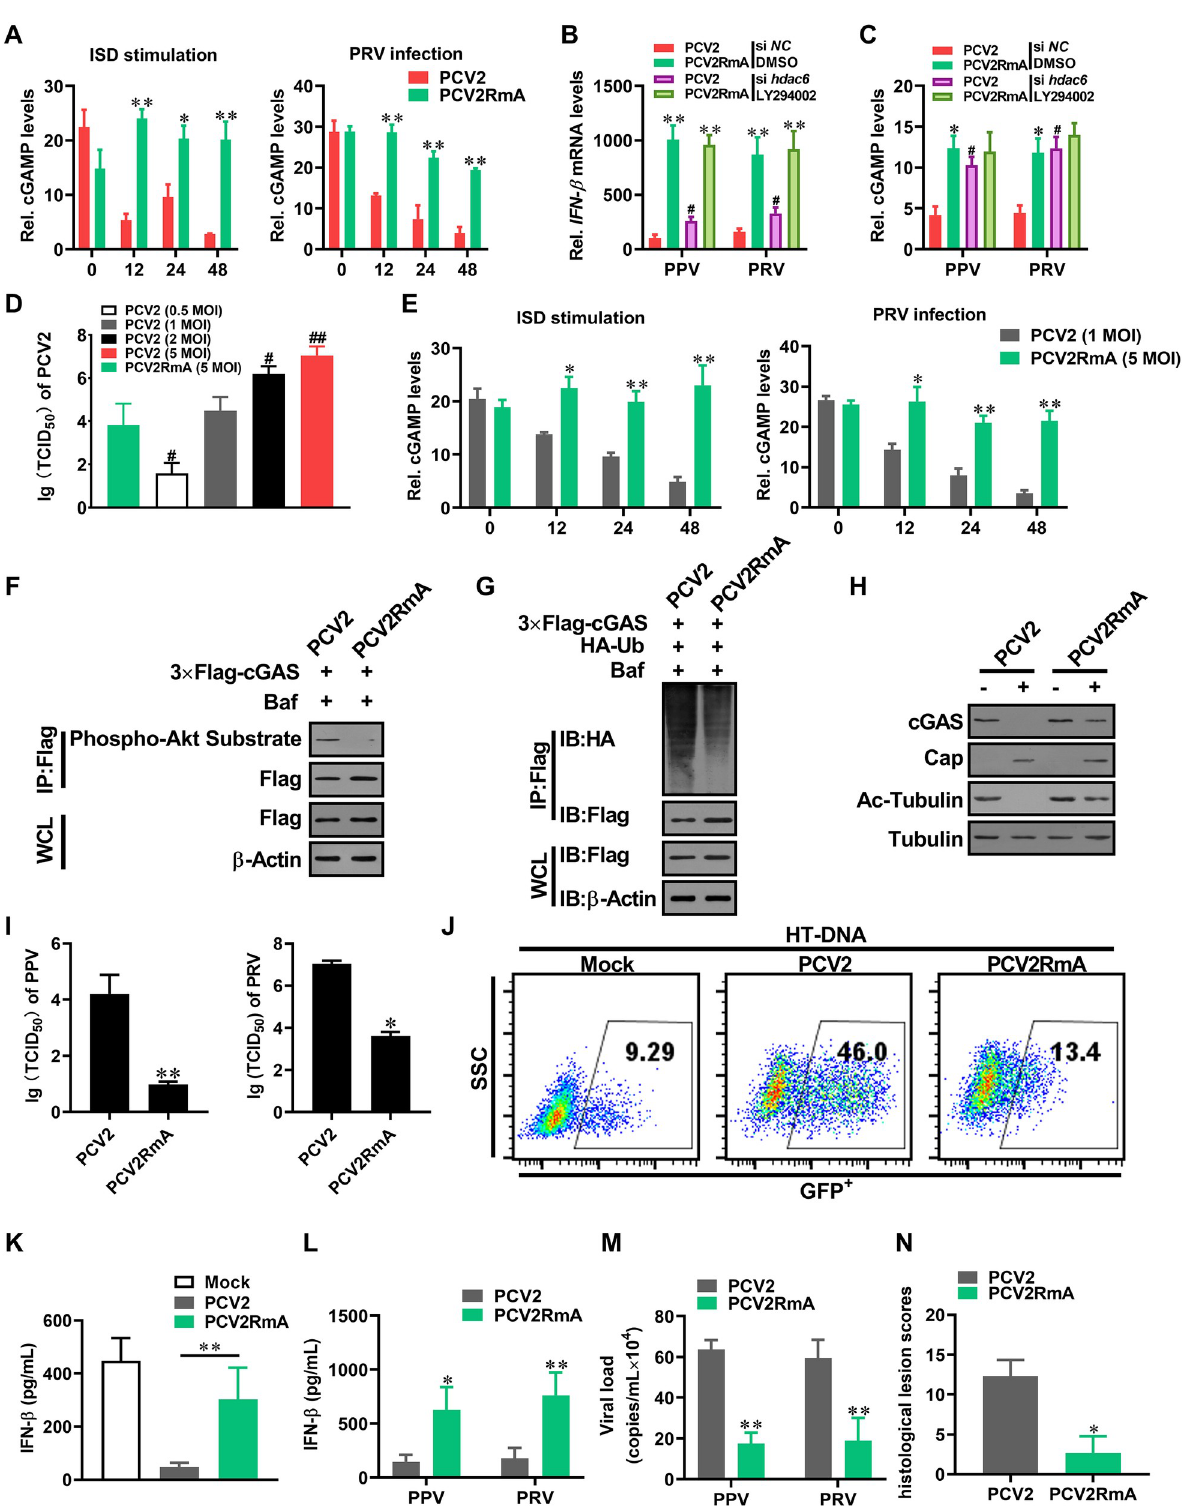
Fig 8. gC1qR-binding activity deficient PCV2 mutant (PCV2RmA) shows a weakened inhibitory effect on IFN- β induction and a weaker boost effect for other DNA viruses. (A) PCV2RmA exhibits a lower inhibitory effect on other DNA-induced cGAMP compared with wild type PCV2. PK- 15 cells were infected with wild type PCV2 (MOI = 5) or PCV2RmA (MOI = 5) for the indicated time, and then the relative cGAMP production